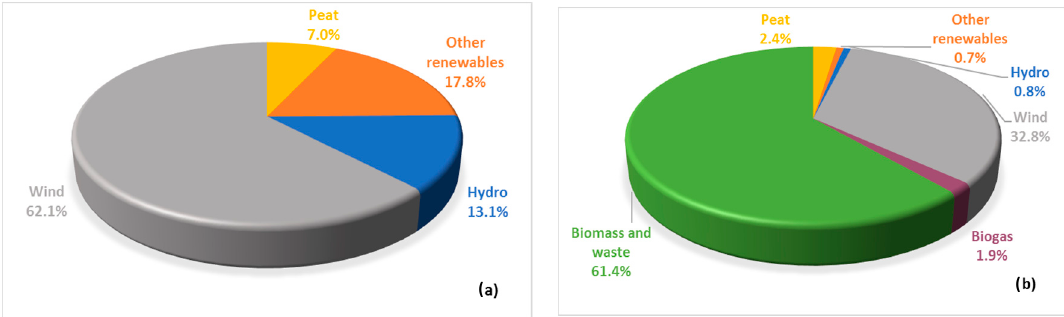
Figure 2. The distribution of electricity generation from different renewable energy sources in Estonia: ( a ) 2008 and ( b ) 2018 [30].